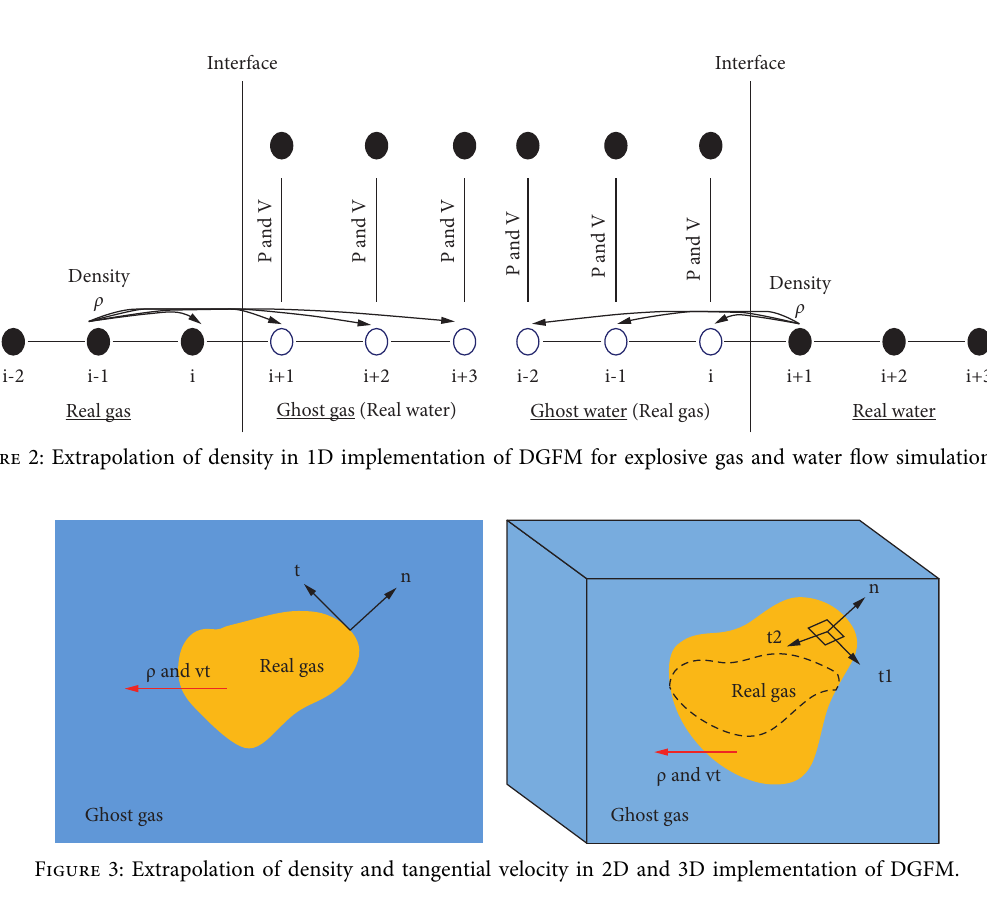
Table 1: Cases simulated by RKDG-DGFM. Case